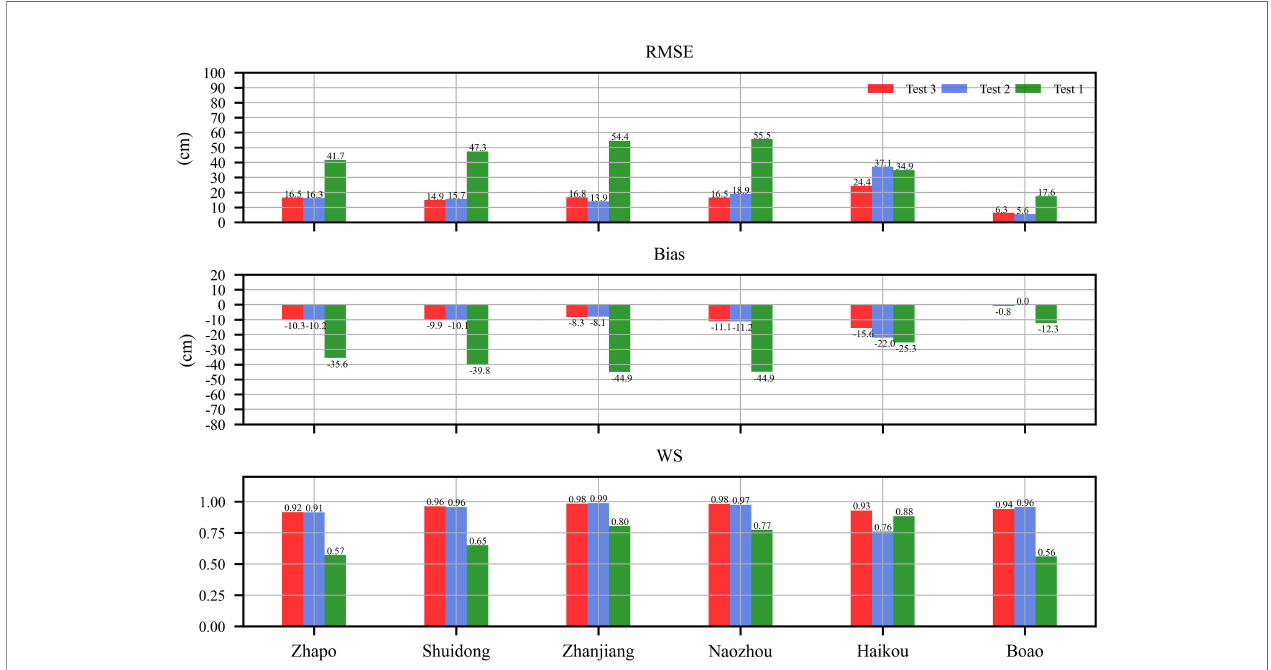
FIGURE 5 | Statistical errors (RMSE and bias) and Willmott skill (WS) between observed and simulated storm surges heights (cm) under different tests at the six tide gauge